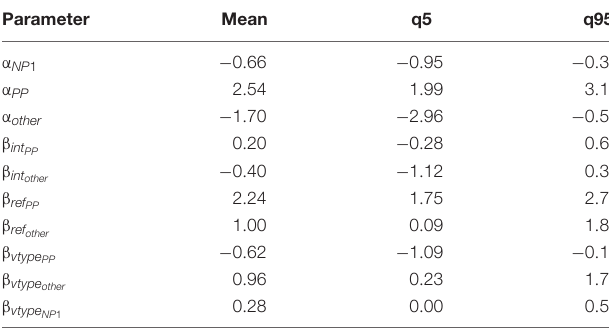
TABLE 5 | Mean estimate and credible interval for the parameters of the Bayesian model, Experiment 1.